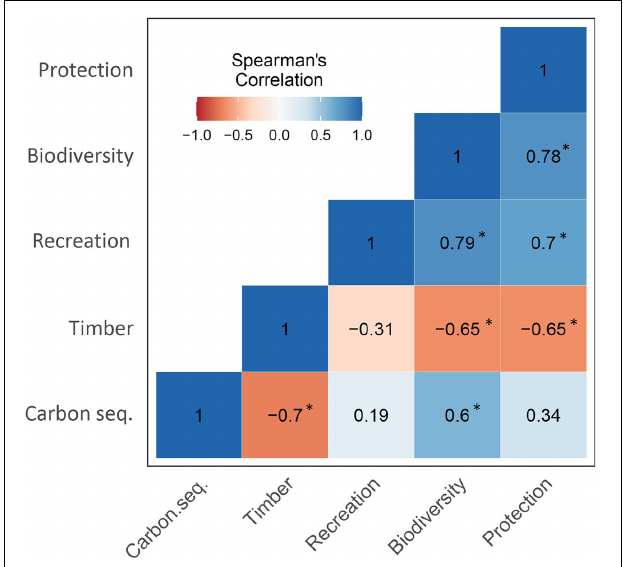
FIGURE 4 | Spearman rank-correlation matrix between biodiversity and ecosystem service (BES) indicators for all case study enterprises (mean of partial utilities over simulation timespan for all management strategies under present climate conditions. Results from future climate scenarios were virtually identical and therefore not shown). Negative values (red) indicate a trade-off (negative correlation) and positive values (blue) a synergy (positive relationship) between BES. The strength and direction of the correlation is expressed by Spearman’s rank correlation coefficient ( n = 12, with asterisk indicating significance, p < 0.05). Site-specific results are provided in Supplementary Appendix Figure 2.1